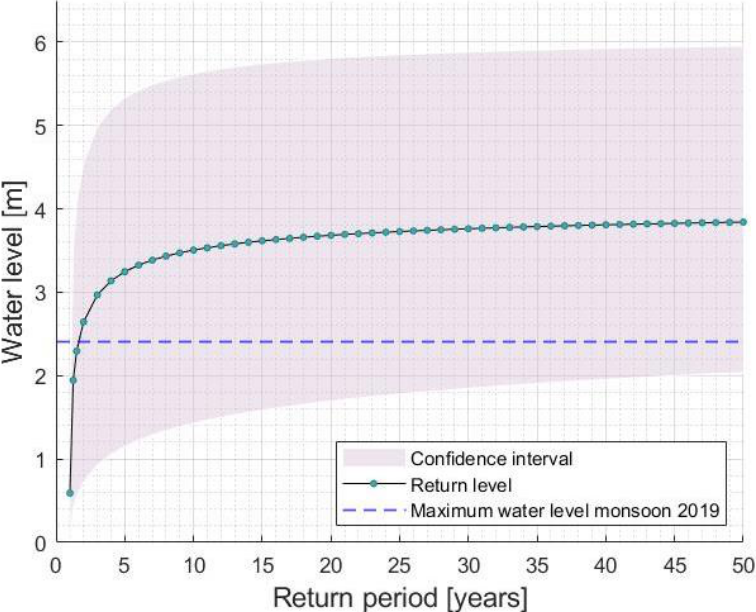
Figure 7. Return periods for the water levels at the Hanumante River (dots), together with the 90% confidence interval resulted from DM’s 5% and 95% quantiles